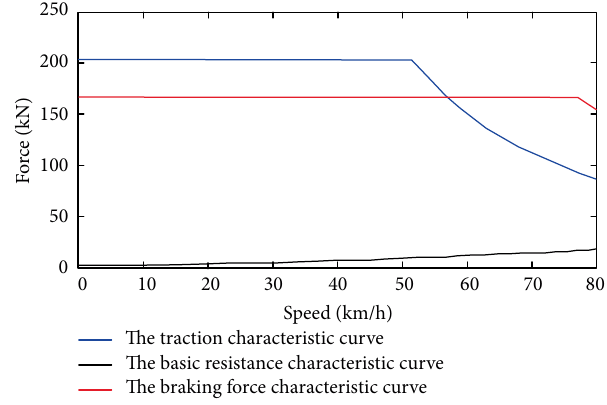
Figure 2: The traction, basic resistance, and braking force characteristic